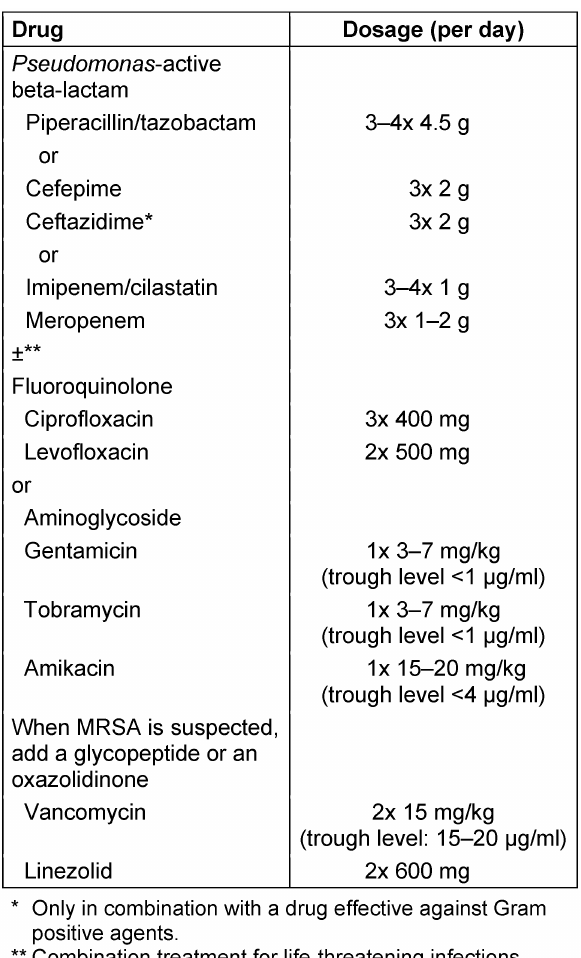
Table 11: Recommendation for the calculated parenteral initial treatment in patients with nosocomial pneumonia and risk factors for multidrug-resistant pathogens (adapted after [3])